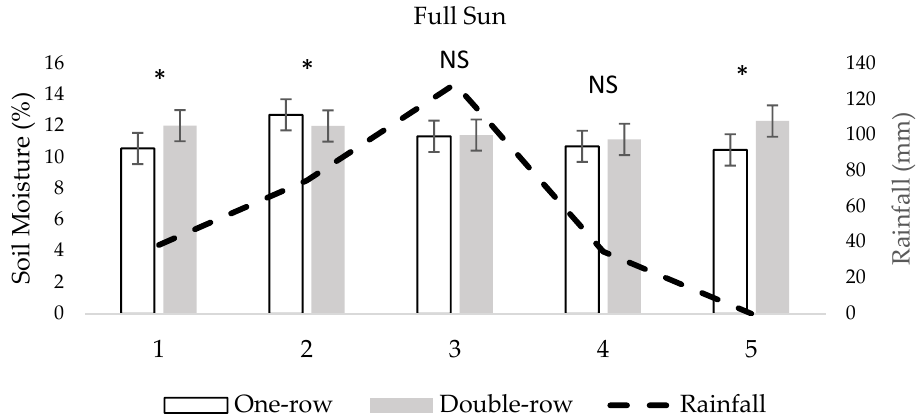
Figure 8. Soil moisture between trees and in full sun for harvested and unharvested area. Values are averages of different months, replications, collection points, and harvesting management (SE = 0.92). NS indicates that LSMEANS are not different according to PDIFF adjusted by Tukey ( p > 0.05) and * denotes significance ( p < 0.05) using the same procedure.